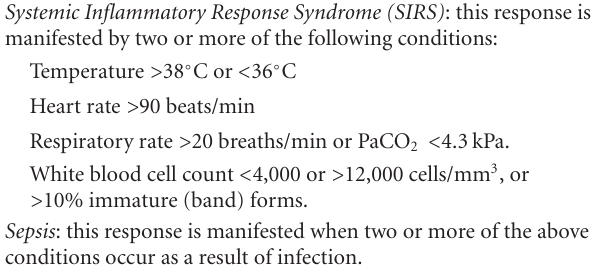
Table 1: Definitions of SIRS, sepsis, and MODS. Modified from American College of Chest Physicians/Society of Critical Care Medicine Consensus Conference. Definitions for sepsis and organ failure and guidelines for the use of innovative therapies in sepsis, 1992.